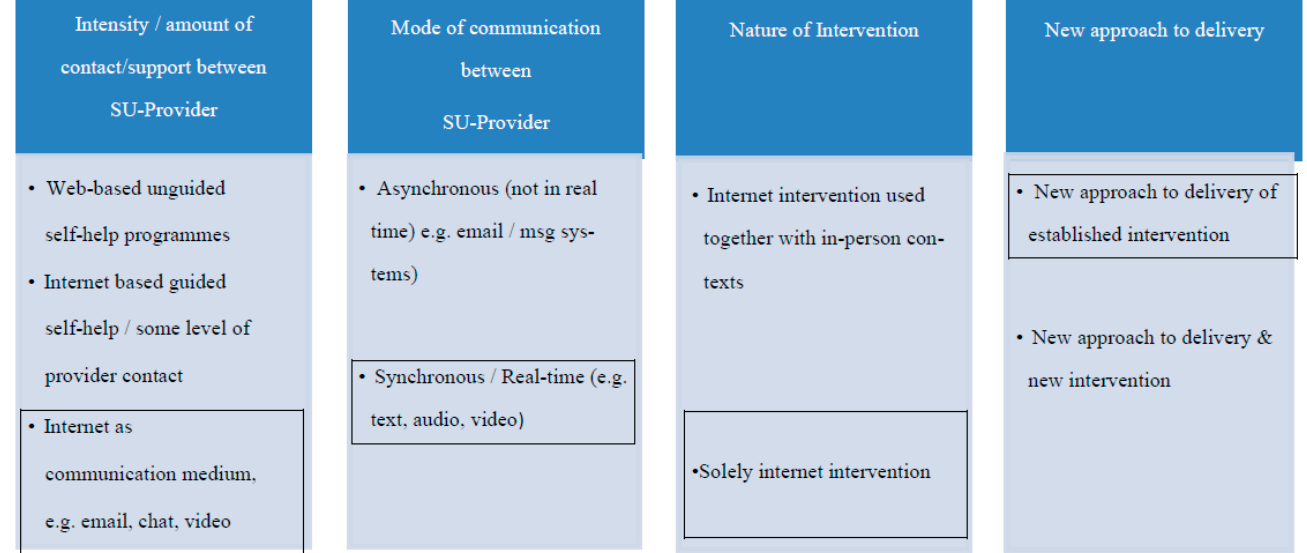
Figure 1. A typology of virtual health options. Source: Adapted from Berger, 2017